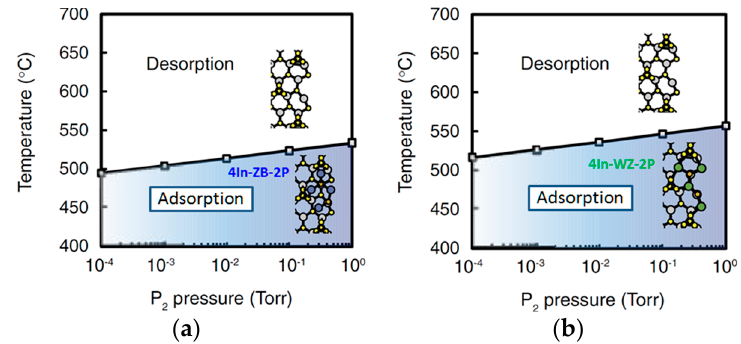
Figure 21. Calculated phase diagrams of ( a ) 4In-ZB-2P and ( b ) 4In-WZ-2P adsorbed surfaces as functions of temperature and P 2 pressure. In pressure is taken to be 3.3 × 10 − 3 Torr. Colored regions correspond to the atom-adsorbed regions. Reprinted with permission from [95]. Copyright (2011) by the Japan Society of Applied Physics.